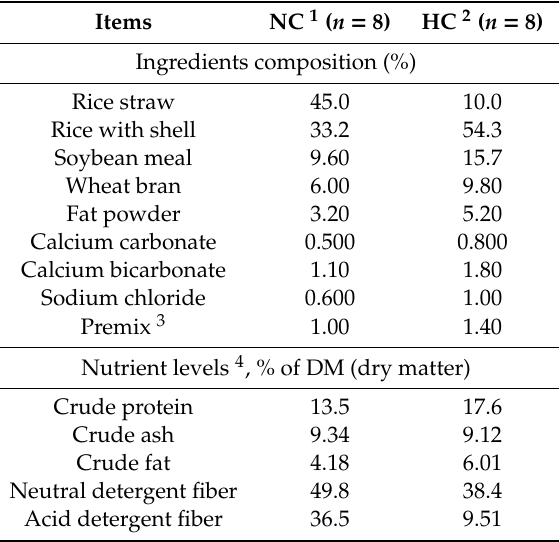
Table 1. Ingredients and nutrient levels of the experimental diets for sixteen goats (air-dried